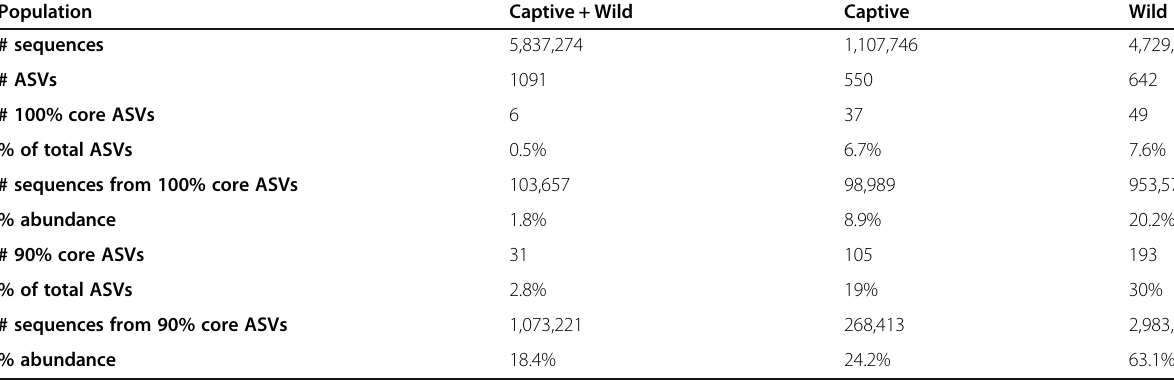
Table 1 Core ASV statistics between and within different SHNW populations Population Captive + Wild